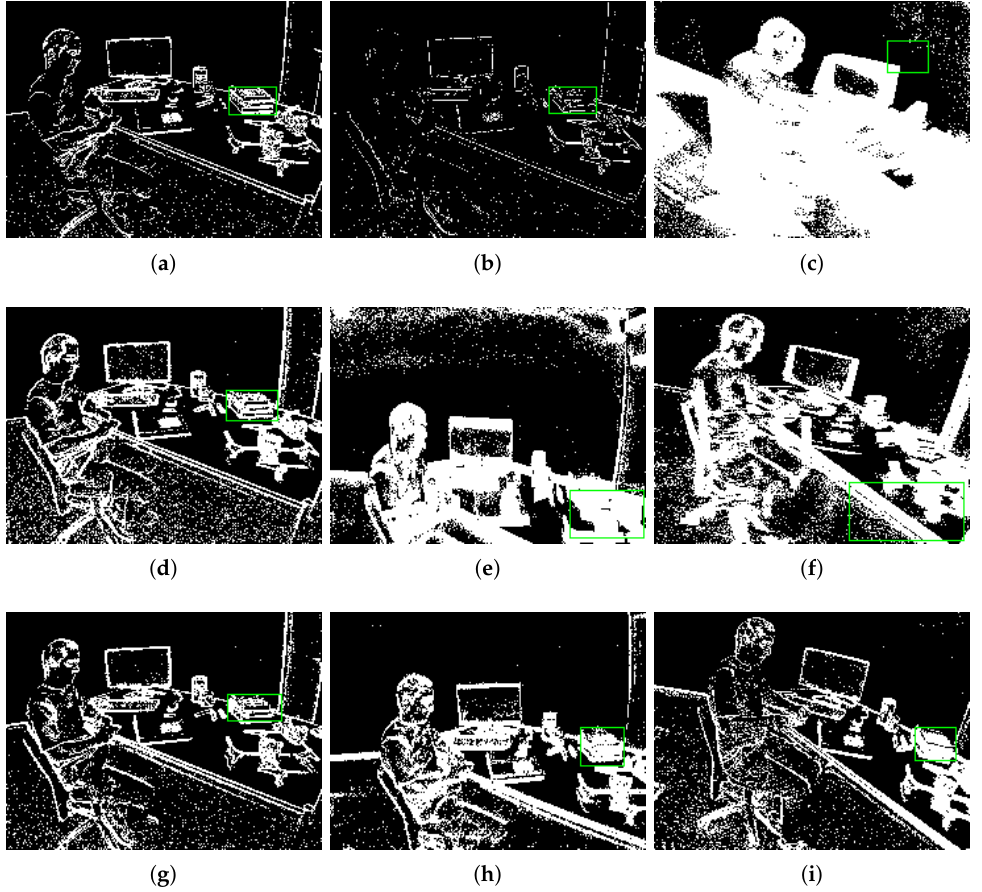
Figure 9. Here, we use three sets of visualized result images for analysis and comparison. ( a – c ) show the visualization results of using time windows to gather event data. ( d – f ) show the visualization results of gathering event data under the condition of a fixed number of event pixels. ( g – i ) show the visualization results of using our dynamic adaptive strategy to gather event data and object tracking. The green box represents the bounding box of the